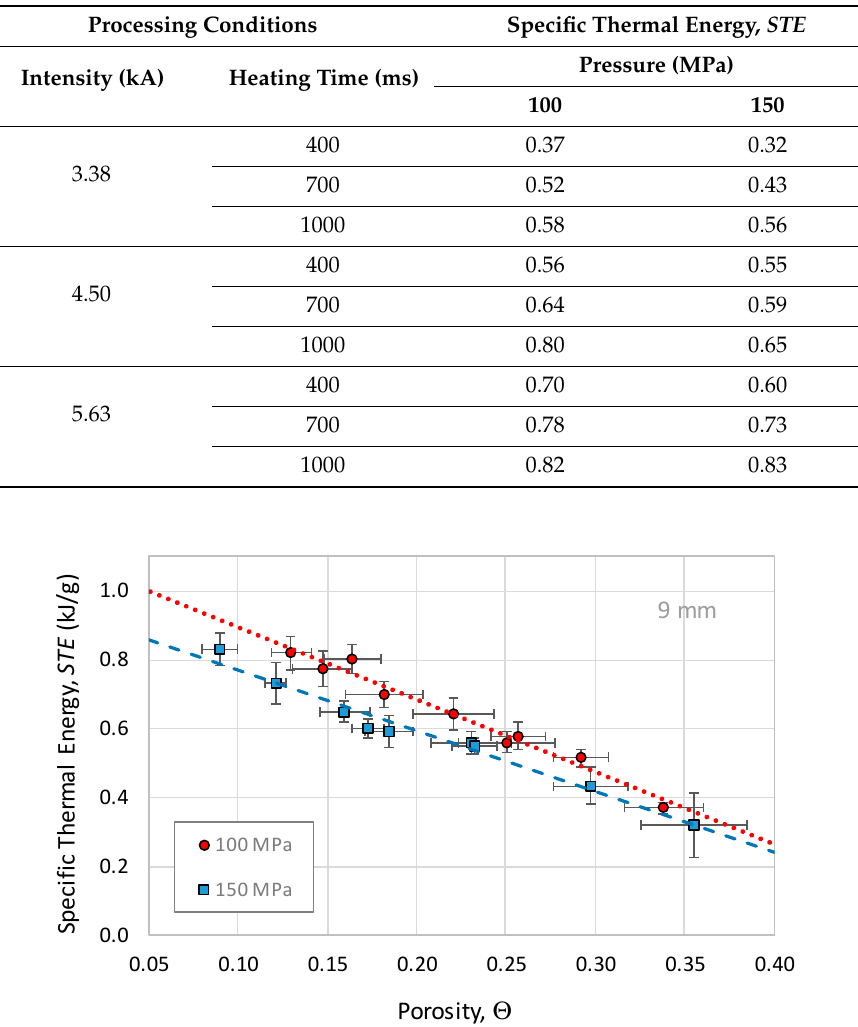
Figure 6. Specific thermal energy versus porosity ( Θ ) for both applied pressures and different intensities and current passing times in 9 mm in diameter compacts. Lines represent the trend of the two sets of points.